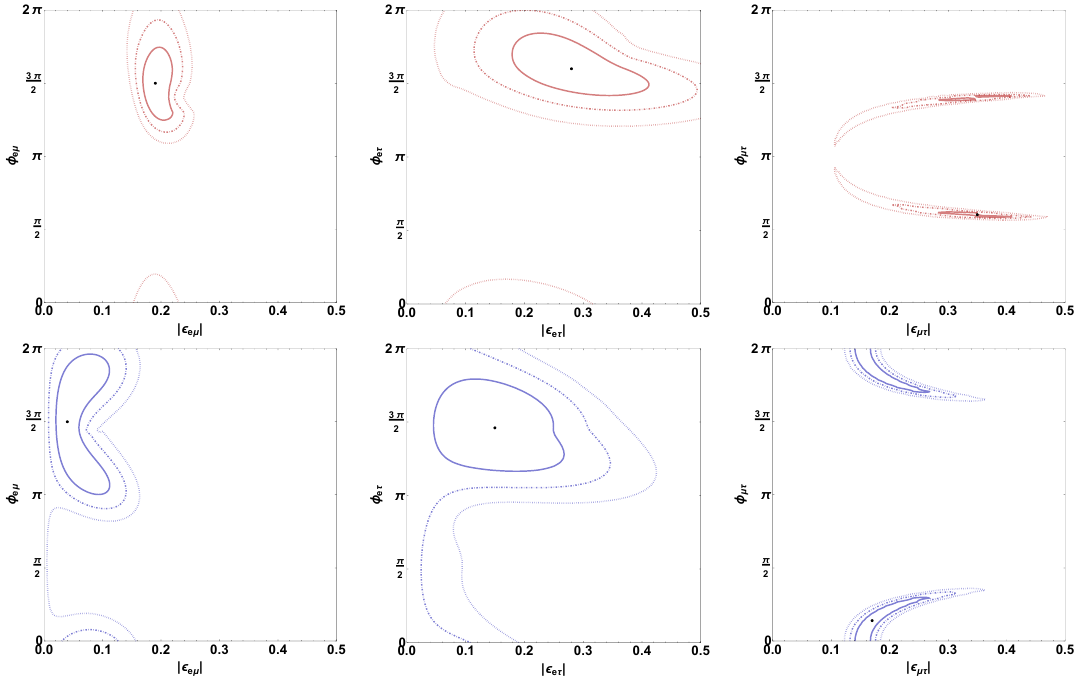
Figure 3 . 68% (solid lines), 95% (dashed lines) and 99% (dotted lines) contours in DUNE in the vector NSI ( | ε ) -planes when data are generated using NSI best fits marginalizing over all ij | − φ ij the NSI parameters. The three top (bottom) plots with red (blue) contours have been obtained using NO (IO) best